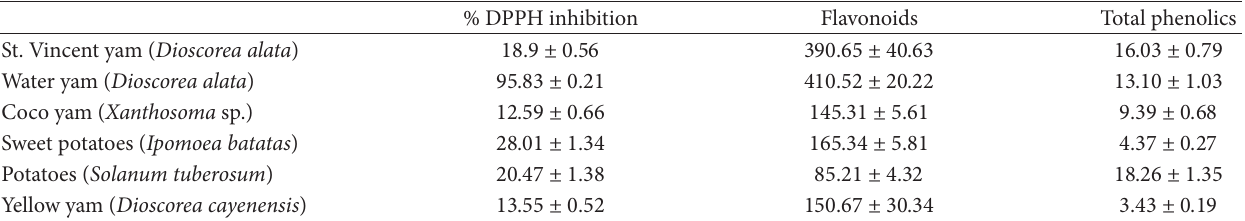
Table 3: Percentage of 2,2-diphenyl 1-1-picrylhydrazyl (DPPH) radical scavenging activity, flavonoids, and phenolic content of selected tuber